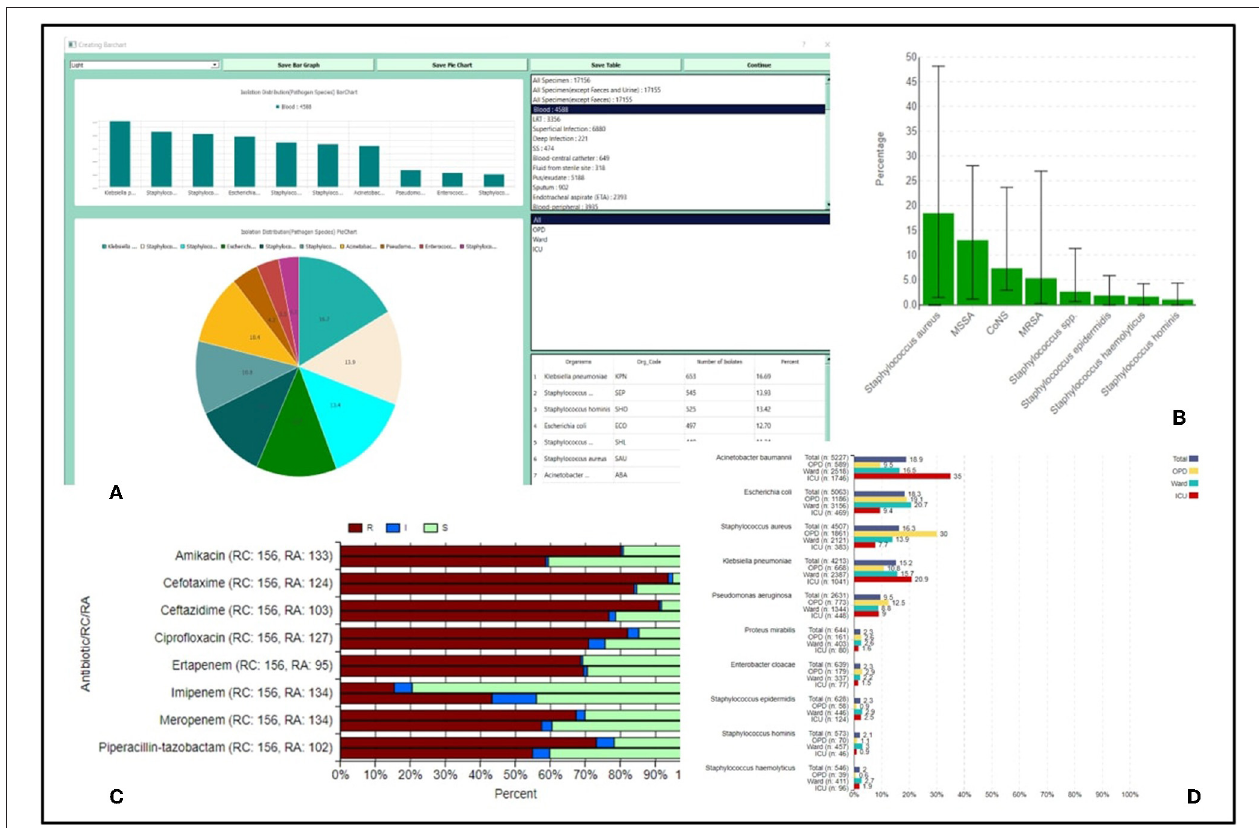
FIGURE 2 | (A) Isolation distribution of top 10 organisms isolated from specimens and organism groups based upon the location type; (B) Bar graphs representing isolation percentage of Staphylococcus species across all regional centers; (C) Stacked bar charts giving a comparative account of RIS in a regional center as compared to rest regional centers in the network; (D) Bar charts location-wise resistance percentage of antibiotics tested for Klebsellia pneumoniae isolated from all